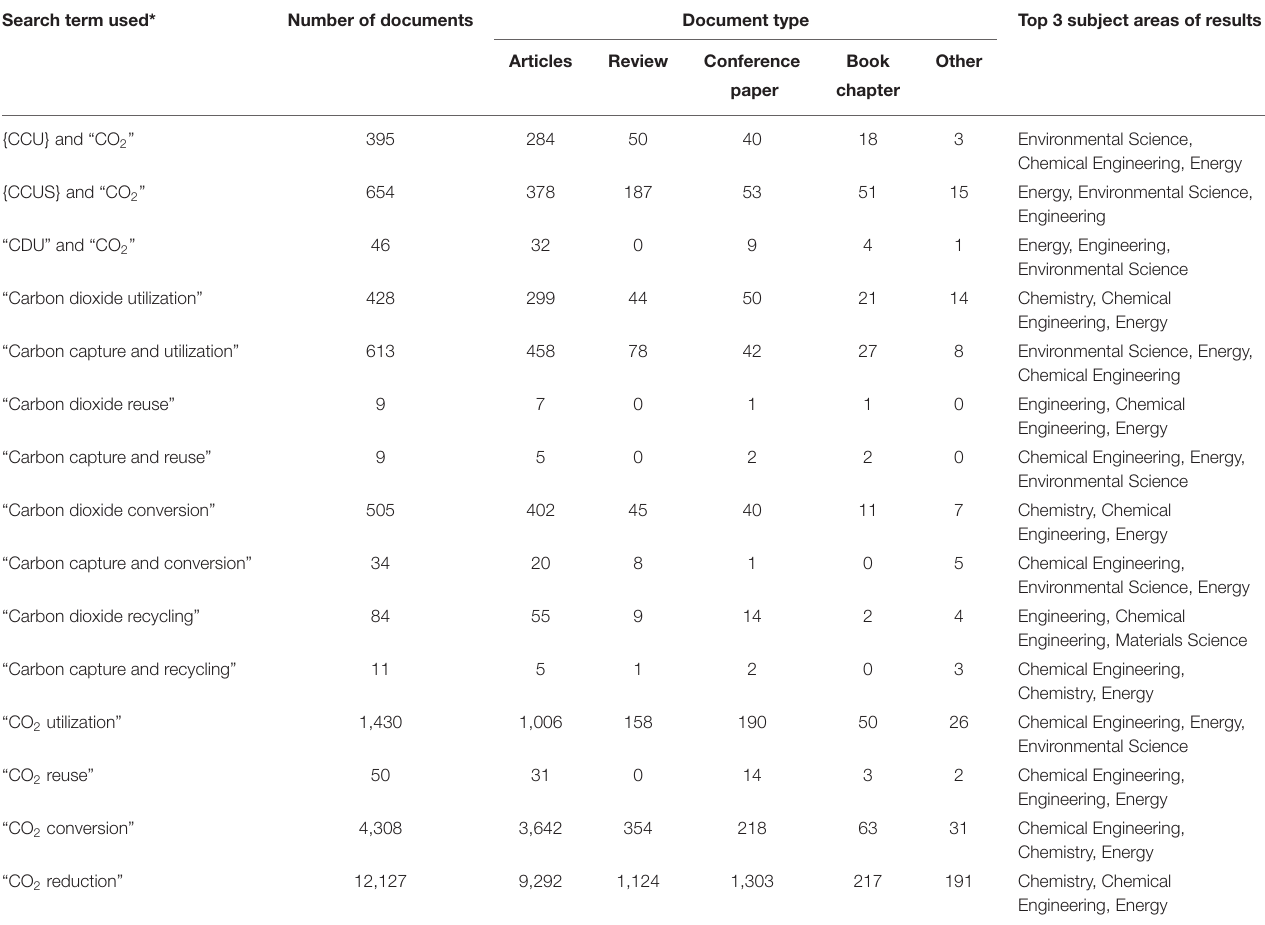
TABLE 1 | Counts of relevant terminology found in Scopus database (accessed February 2nd,